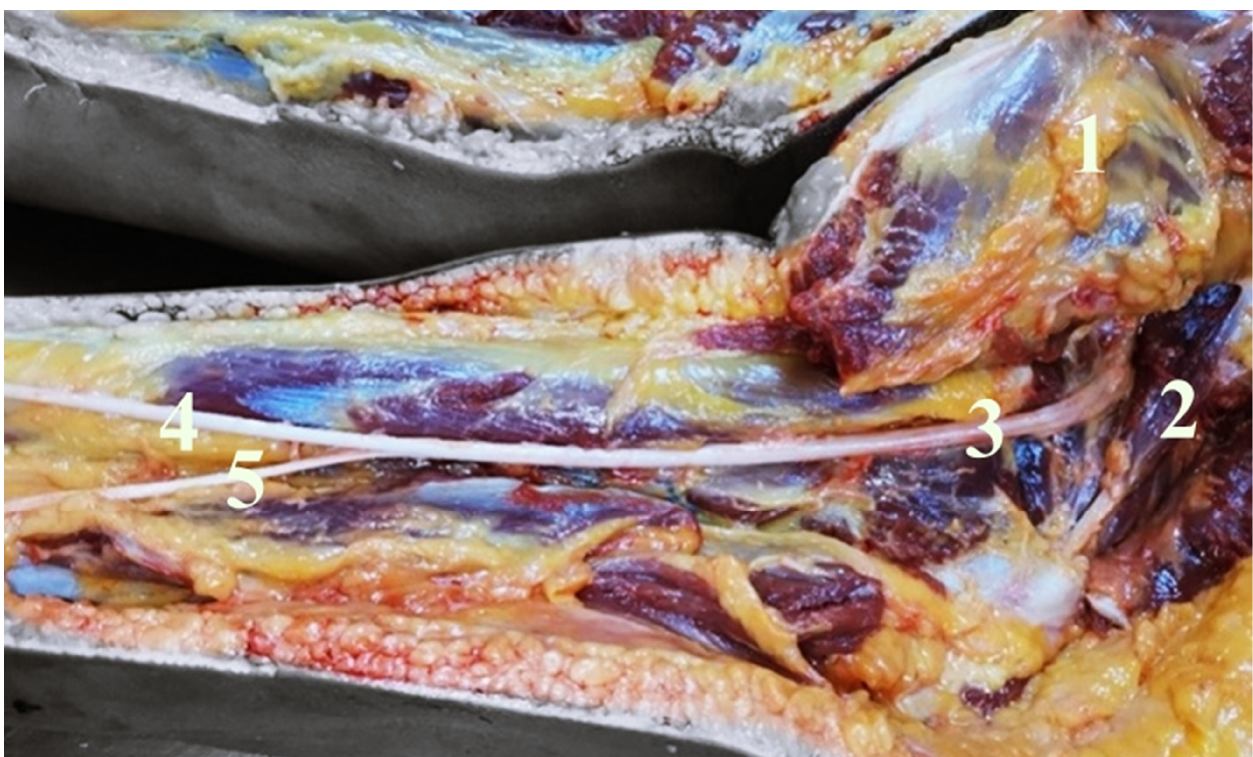
Figure 1. Anatomical drawing shows the relationship of the SN with the PM. SN can exit from the pelvis inferior to the PM ( A ); between the fascicles of the PM and inferior to the PM ( B ); and between the fascicles of the PM and superior to the PM ( C ).